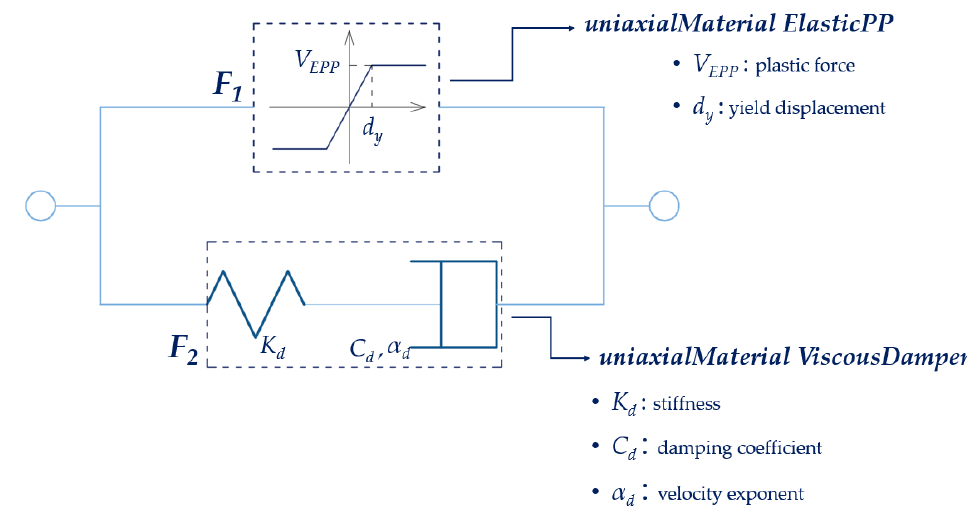
Figure 6. EPPV rheological model in OpenSees.